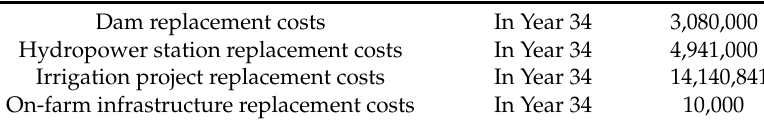
Table A7. Replacement costs (USD).